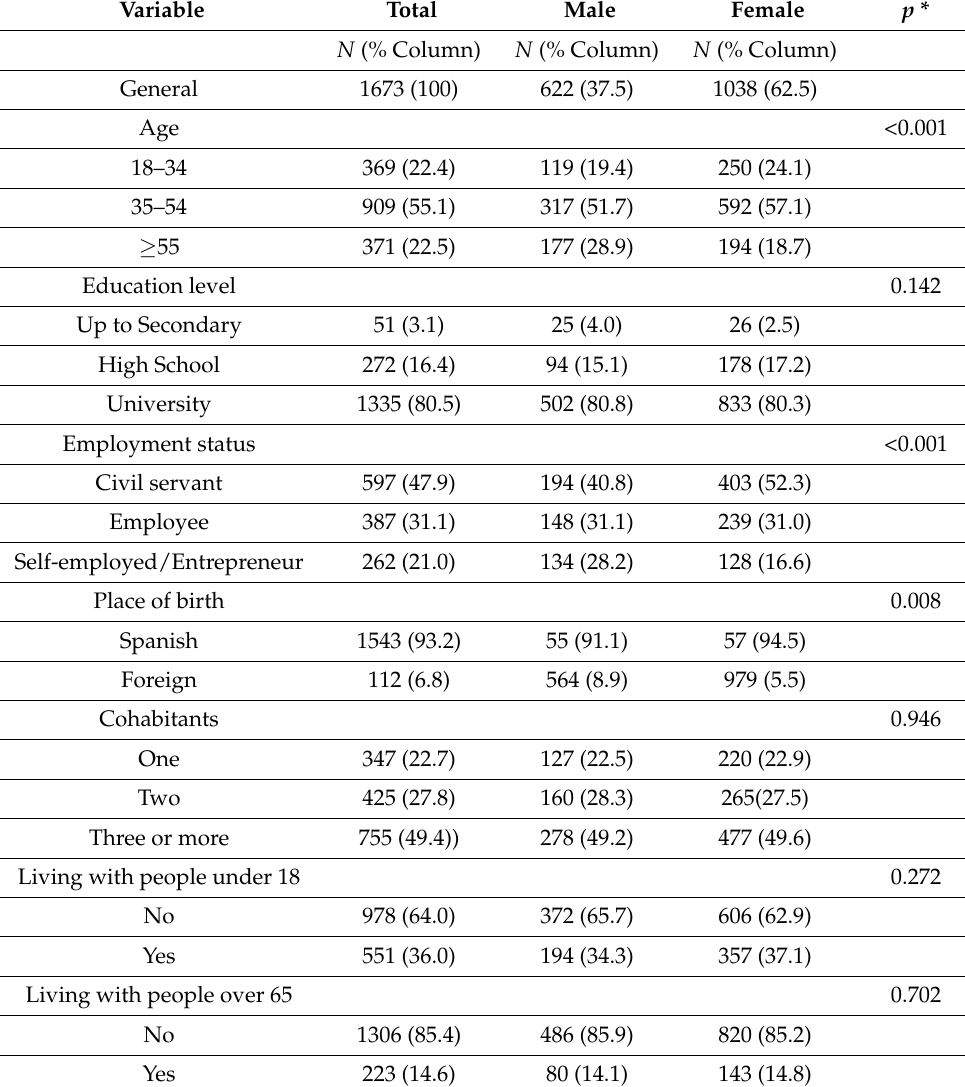
Table 2. Sociodemographic characteristics of the study participants, by gender. Variable